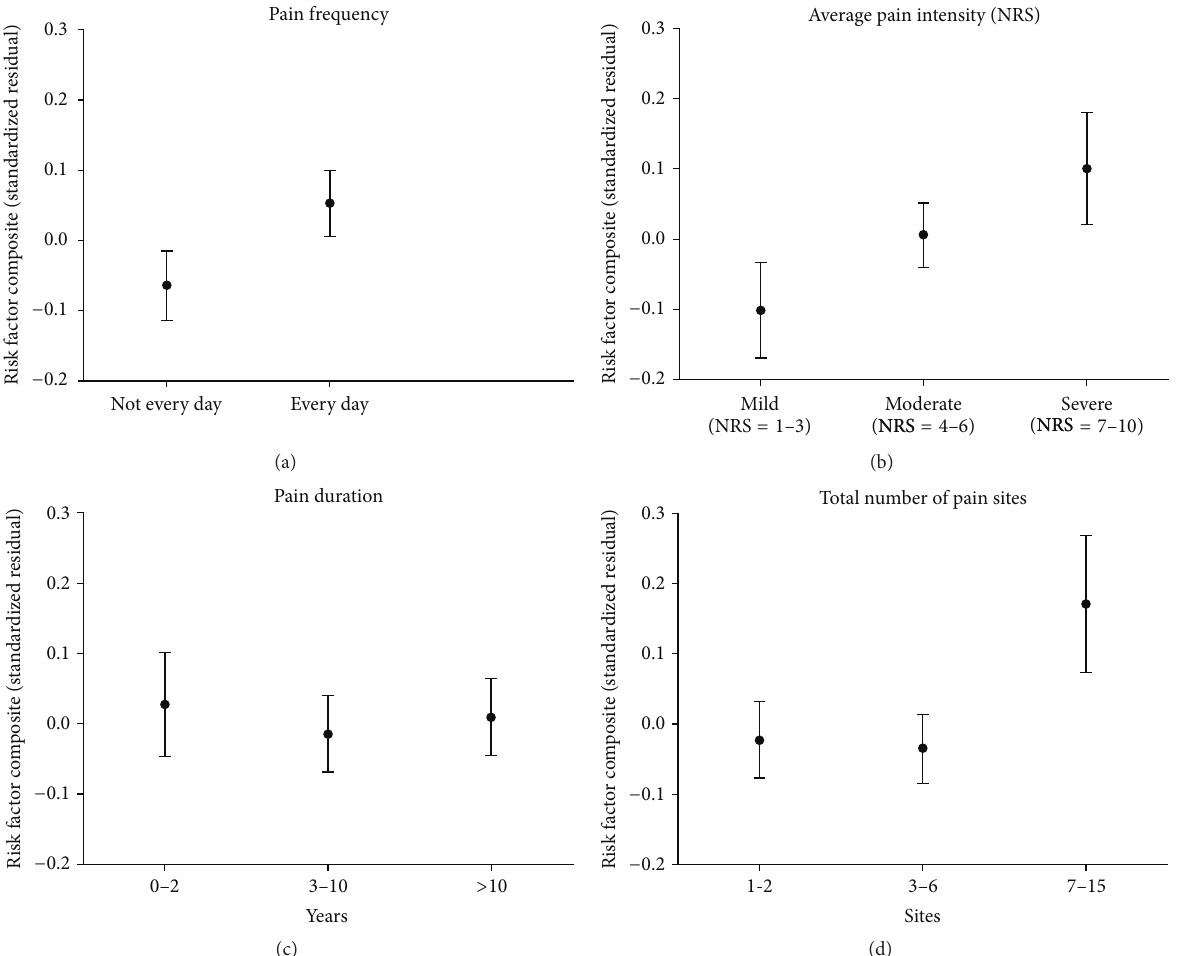
Figure 2: Risk factor composite by pain dimensions. Unique effect of each pain dimension after controlling for sex, age, education, exercise, alcohol consumption, smoking, and remaining pain